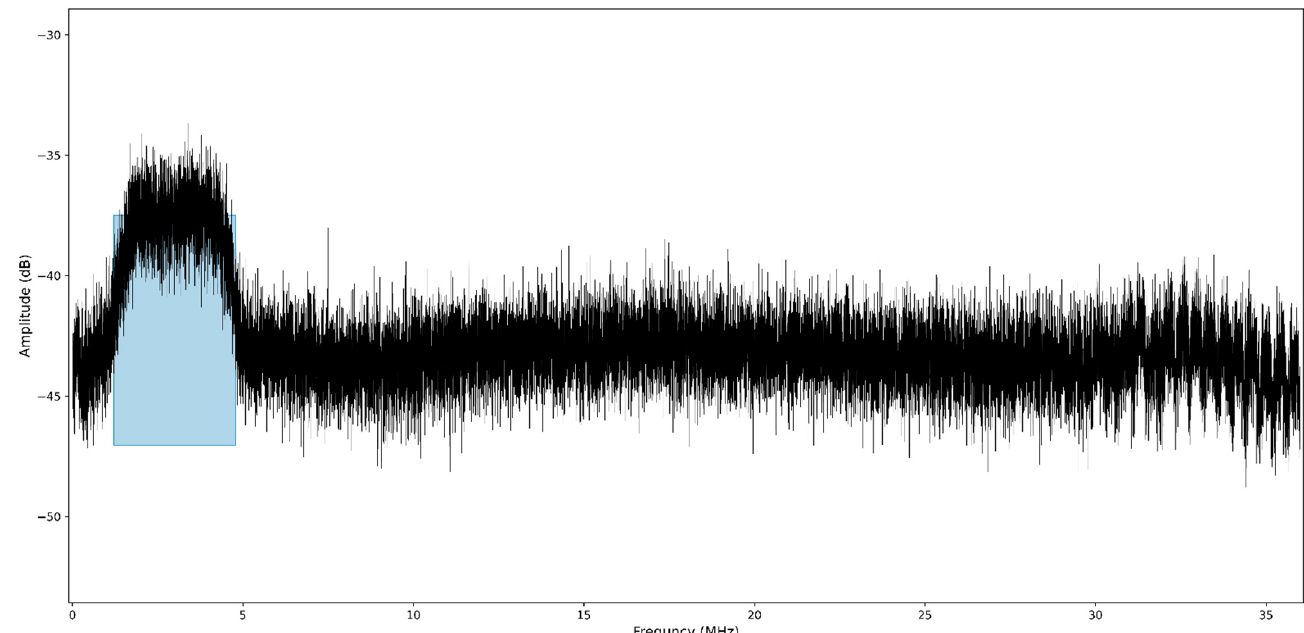
Figure A8. Example8 of the actual satellite broadband power spectrum set.